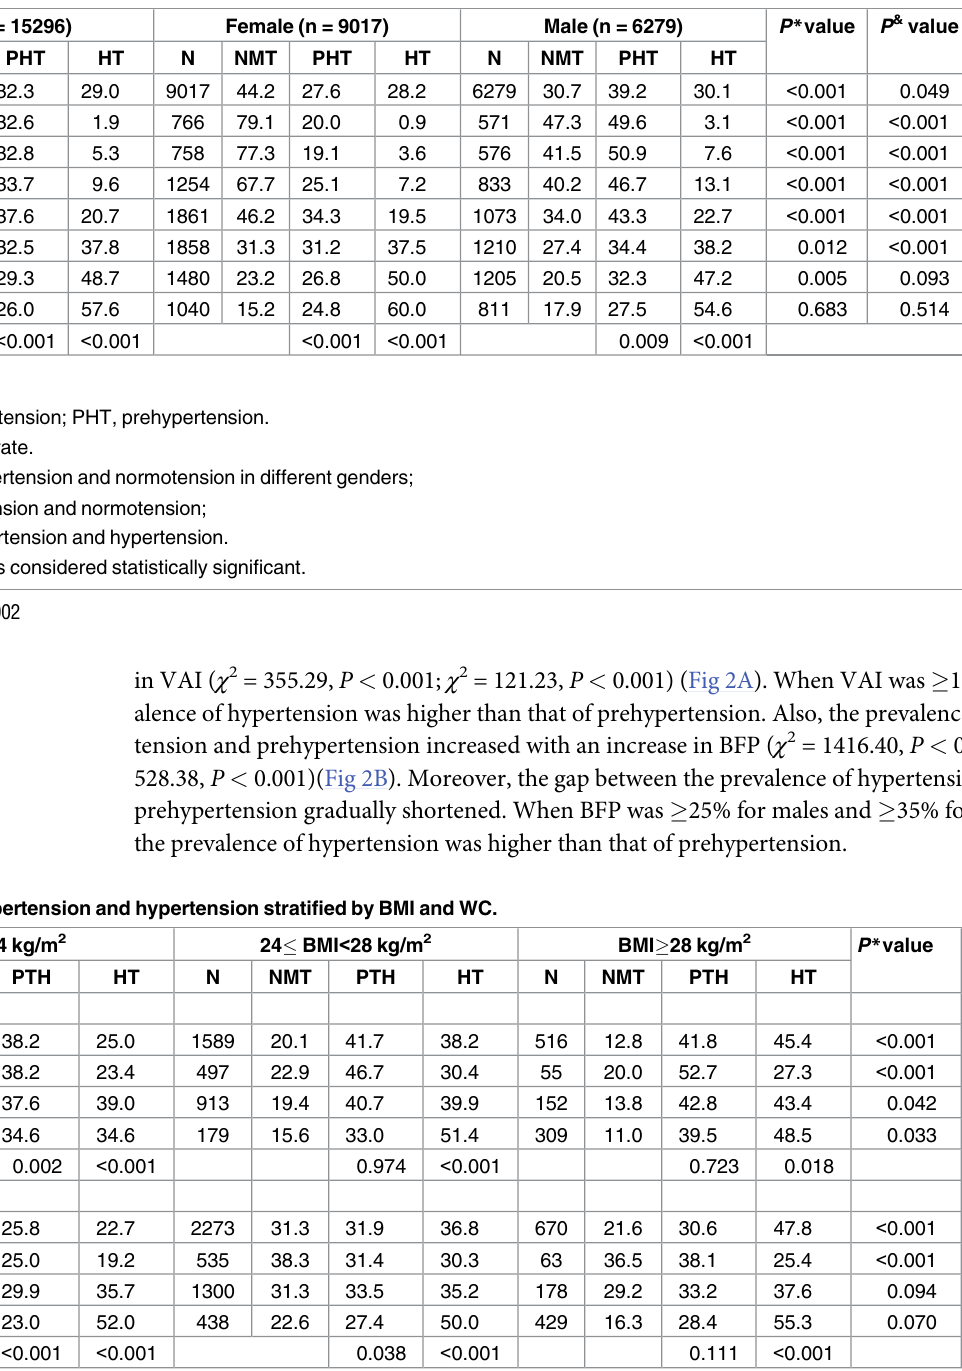
Table 2. Prevalence of prehypertension and hypertension stratified by sex and age.